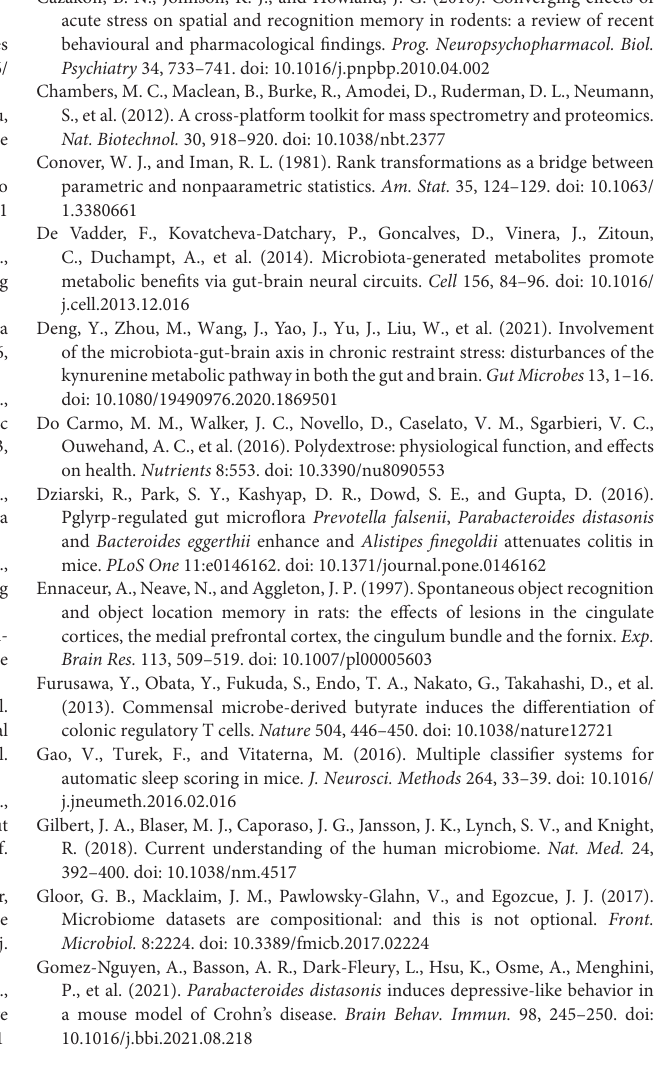
Supplementary Figure 1 | The Prebiotic Diet Causes Changes to Fecal Microbiome Beta and Alpha Diversity. Fecal samples were collected on the day of arrival to the facility (T1), after 4 weeks on diet (T2), at baseline sleep (T3), and at the end of the experiment (T4). 16S rRNA gene microbiome sequencing and analyses were performed. PERMANOVA testing for an effect of diet was performed at each timepoint, and PCoA depicting (A) unweighted UniFrac and (B) weighted UniFrac analysis of beta diversity, with one axis representing timepoint, are reported. Alpha diversity was measured at each timepoint using (C) Faith’s phylogenetic diversity index, (D) the total number of OTU, and (E) Pielou evenness metric. Mixed-effect modeling testing for an effect of timepoint, diet, and interactions was performed for each dependent variable, and significant results are reported in the figure. Data are mean + SEM. Symbols: (A,B) ∗∗∗ p < 0.001, ∗∗ p < 0.01, PERMANOVA; (C–E) ∗∗ p < 0.01, ∗ p < 0.05, Bonferroni post hoc . Abbreviations: OTU, operational taxonomic unit; PC, principal coordinate. n = 33–45/group. Supplementary Figure 2 | Predicted Microbial Metabolic Pathways Altered by the Prebiotic Diet. Fecal samples were collected after 4 weeks on diet (T2), at baseline sleep (T3), and at the end of the experiment (T4). 16S rRNA gene microbiome sequencing and analyses were performed. PICRUSt2 was performed